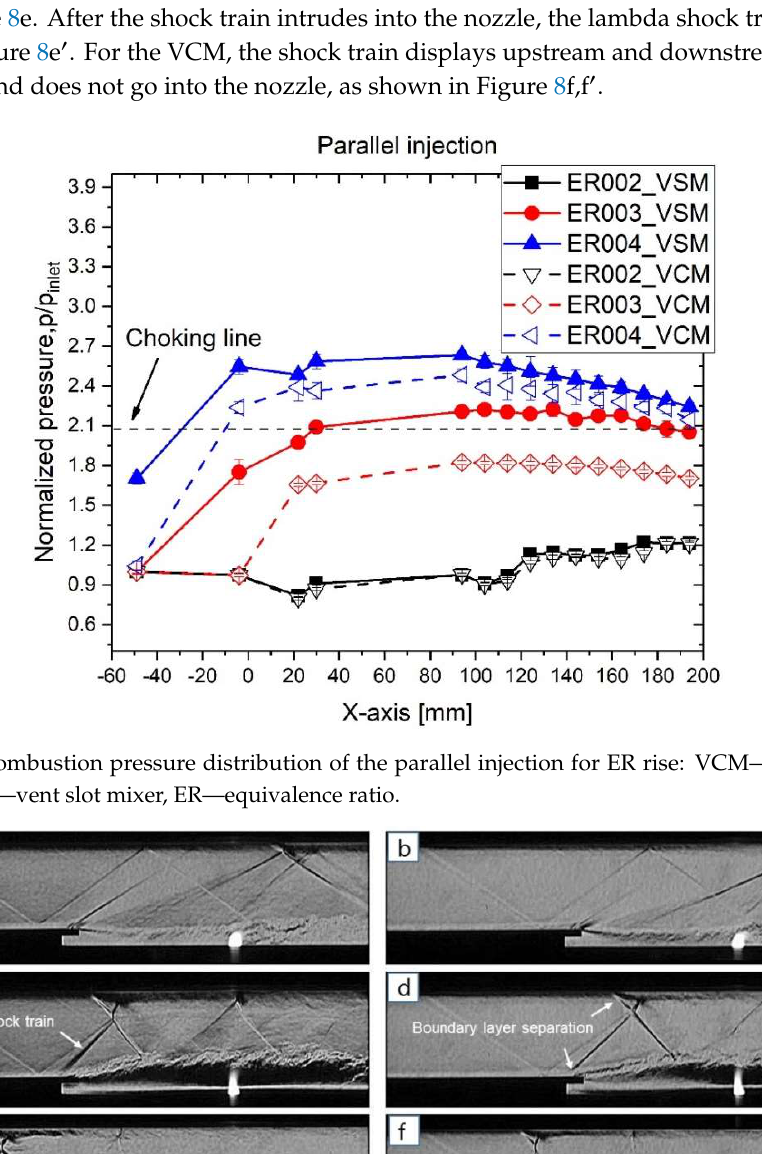
Figure 9. Combustion pressure distribution of the normal 1 injection for ER rise: VCM—vent circle mixer, VSM—vent slot mixer, ER—equivalence ratio. In Figure 11, for the normal 2 injection, there is no thermal choking for all ER ranges. For ER = 0.02, both the vent mixers show the same combustion pressure pattern. For ER = 0.03, the VSM is superior to the VCM in the downstream combustion pressure. In Figure 12, the recompression shock is observed in all figures, and the downstream jet plume fluctuates intensely according to the ER increase. The span-wise combustion pressure measured from span three is displayed in Figure 13.